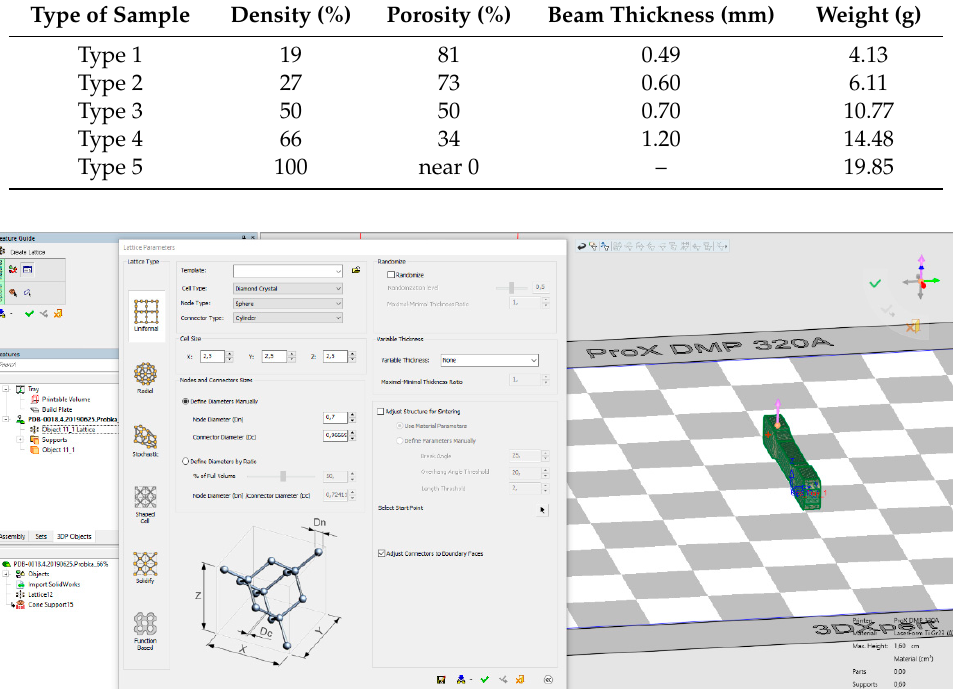
Table 2. Types of samples of Ti6Al4V titanium alloy obtained by the LPBF method used in the tests.